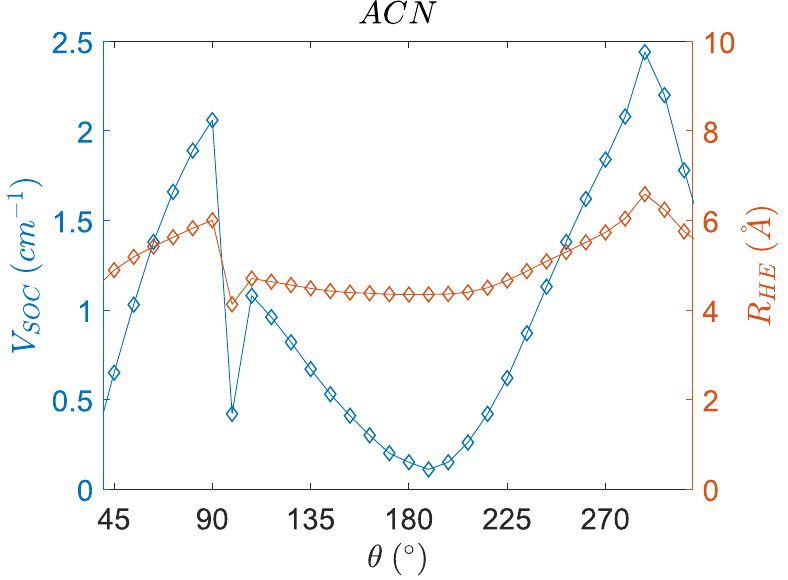
Figure 13. The correlation between the SOCME value and the electron hole distance in ACN. Geometries are calculated with PBE and TZP. The quantities are calculated with the TZP basis and the CAMY-B3LYP functional. Table 7. The center to center distance between pyrene and DMA. The quantity is calculated by taking the average distance between the furthest hydrogen atoms and closest carbon atoms between the donor and acceptor (excluding spacer atoms). The geometries are calculated with the TZ2P basis and CAMY-B3LYP exchange correlation. CRS = charge recombination to the singlet ground state, CRT = charge recombination to the triplet state, CS = charge